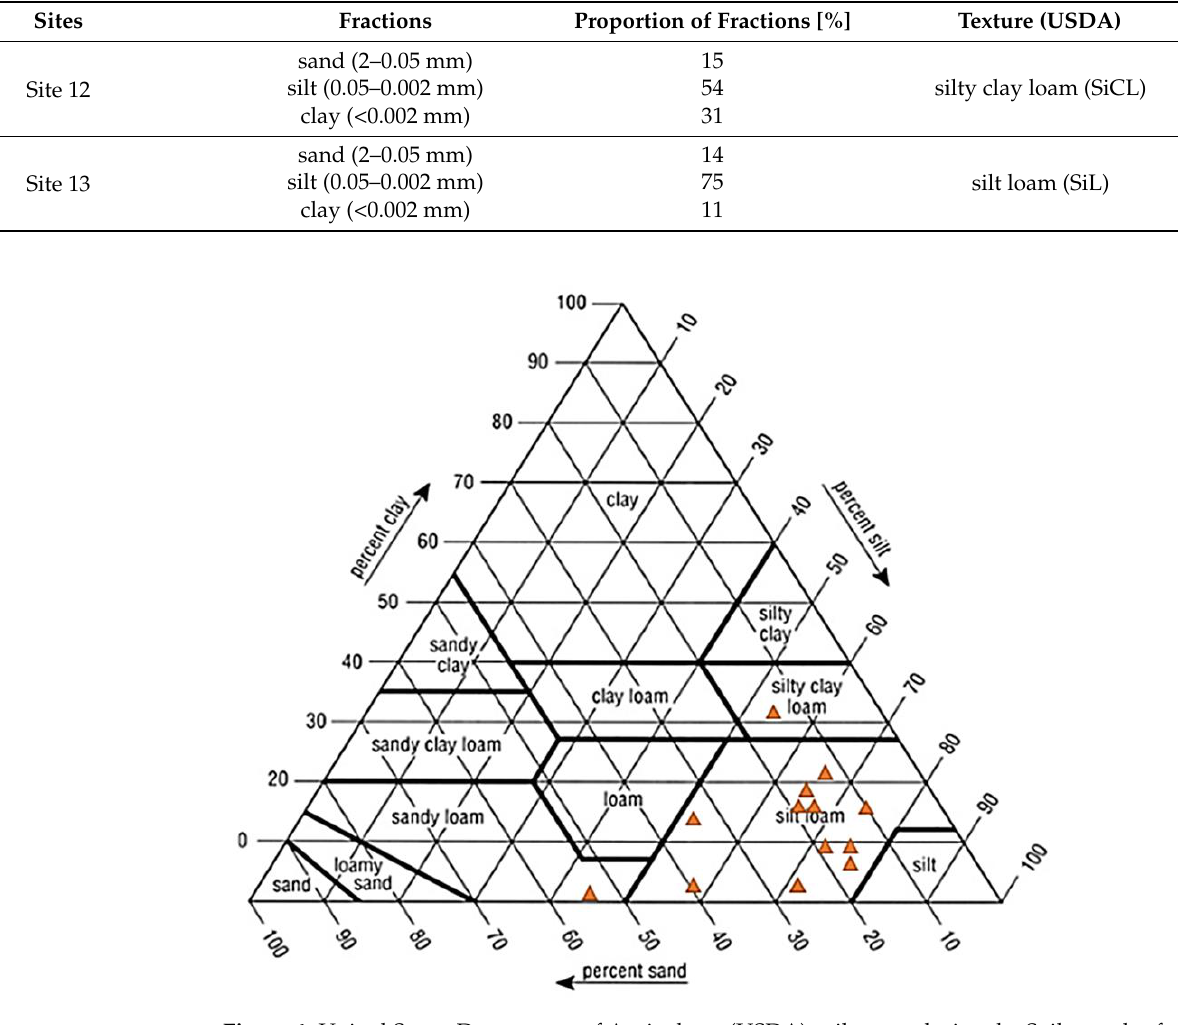
Figure 4. United States Department of Agriculture (USDA) soil textural triangle. Soil samples from individual research sites are marked with triangles [14].